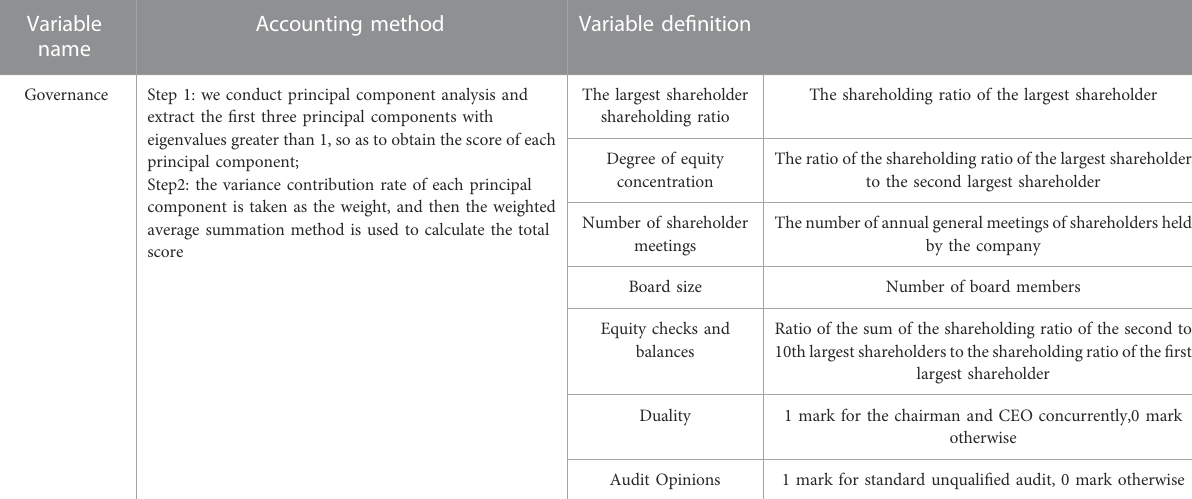
TABLE A3 De fi nitions of corporate governance performance